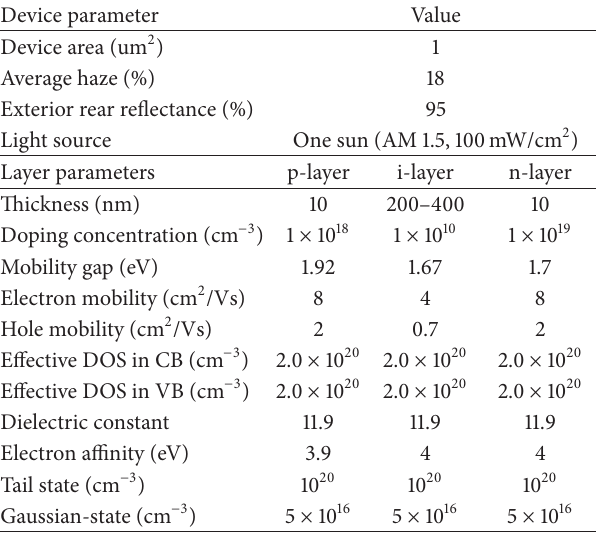
Table 3: The minimum set of input parameters used in our simulation work.